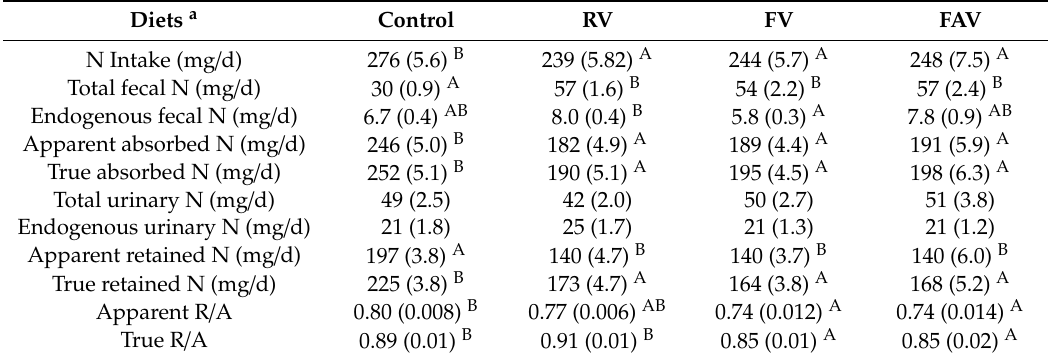
Table 3. Nutritive utilization of protein in rats ( n = 10) fed diets based on casein or cowpea as the only protein sources.